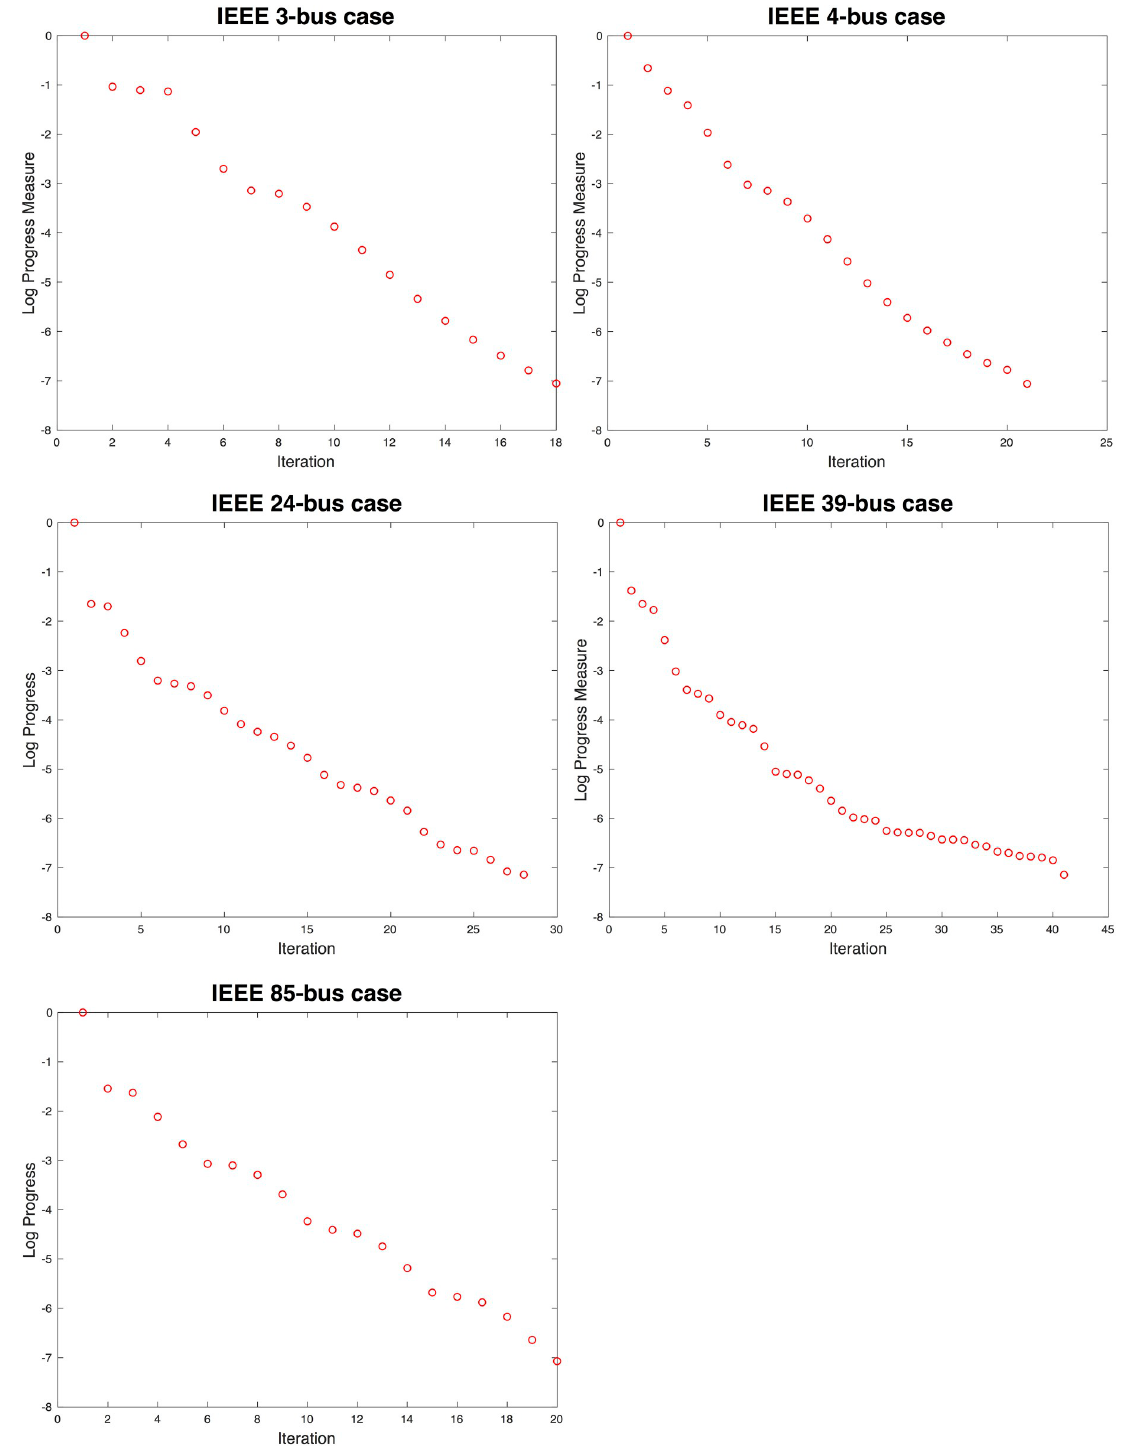
Fig 6. Convergence of proposed algorithm for selected systems (i.e., IEEE 3-, 4-, 9-, 14-, 24-, 39-, and 85-bus systems).